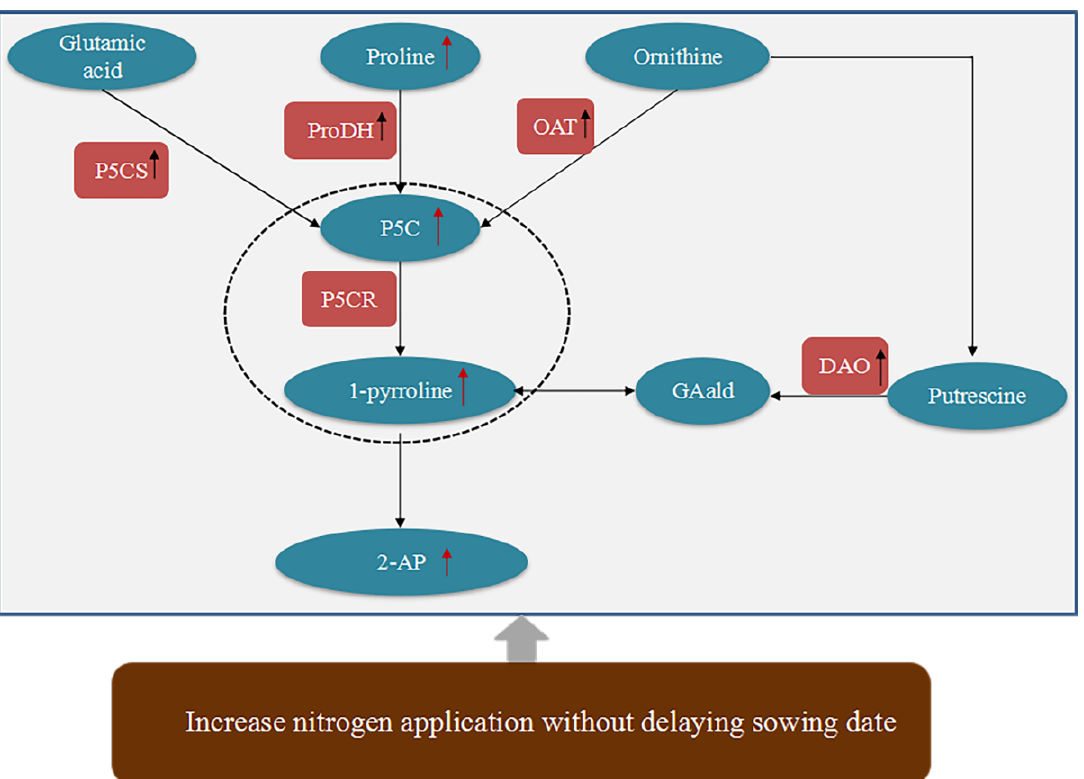
Figure 4. Effects of increased nitrogen application without delaying sowing date on 2-AP synthesis. Note: The red arrows indicate substances involved in 2-AP synthesis, and the black arrows indicate enzymes involved in 2-AP synthesis.